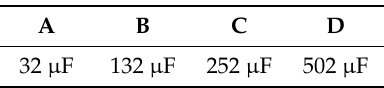
Table 4. Capacitance